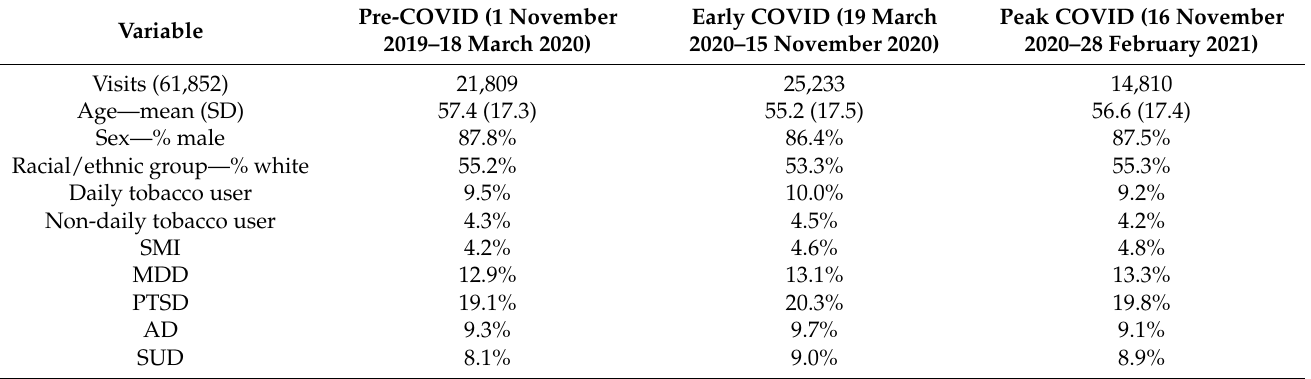
Table 1. Descriptive statistics for key variables during the pre-, early, and peak COVID periods. Variable